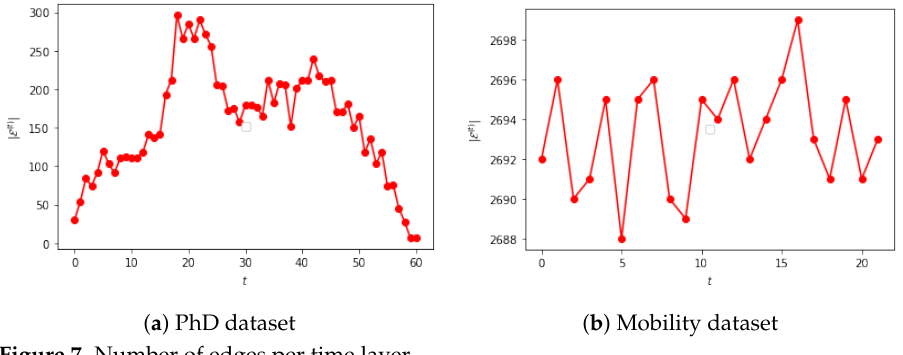
Figure 7. Number of edges per time